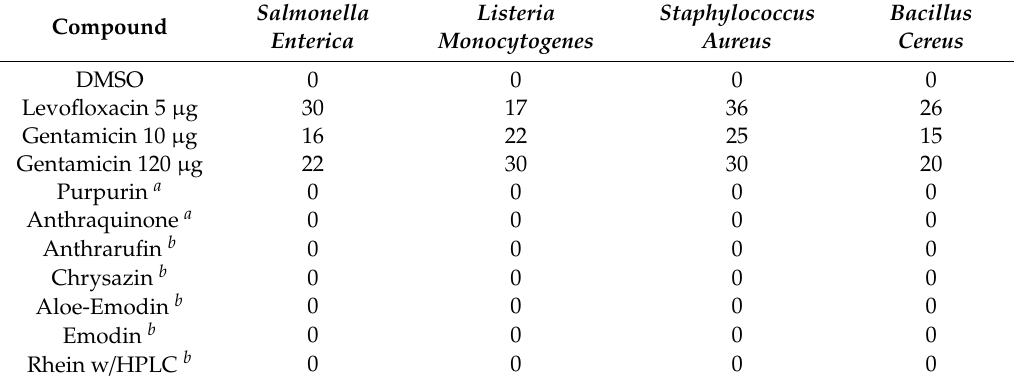
Table 2. Table depicts the zones of inhibition in mm (growth inhibition) from a disc di ff usion assay targeted against bacterial pathogens using DMSO vehicle control, antibiotic controls, and test compounds at indicated concentrations a,b . a at 100 µ M, b at 10 µ M.